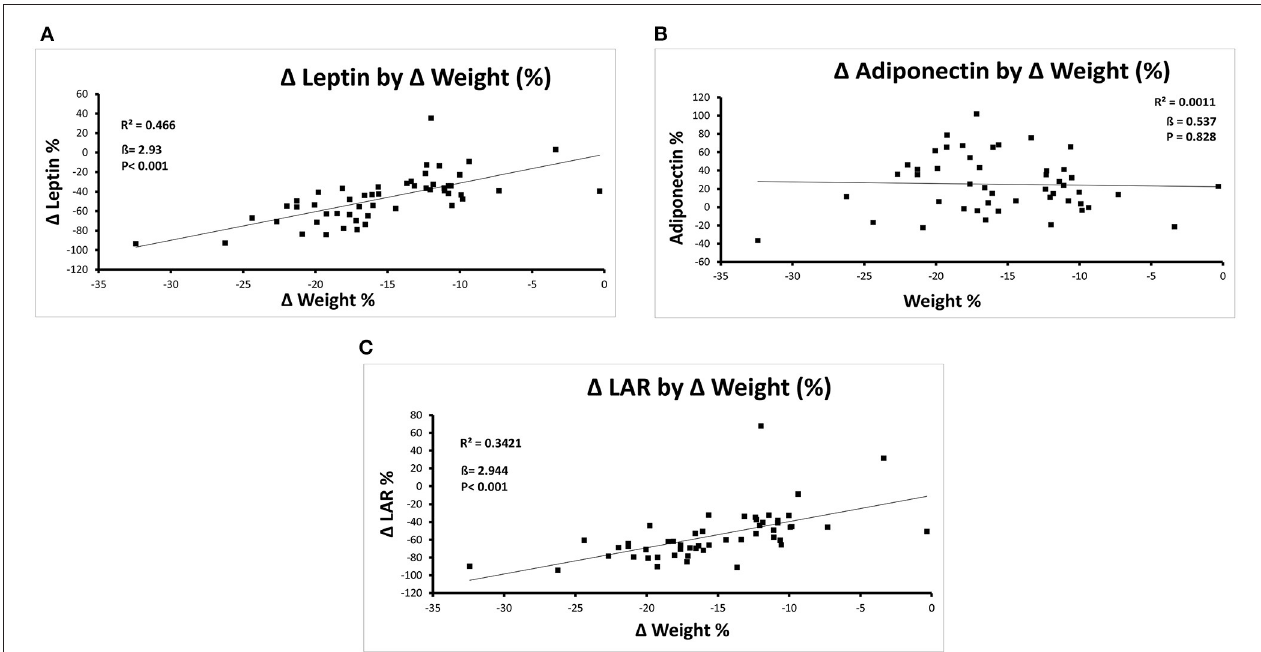
FIGURE 1 | (A–C) Correlations between percentage change in weight and percentage change in leptin (A) , Adiponectin (B) , and the LAR (C) after Completion of the Milk-Based LELD.